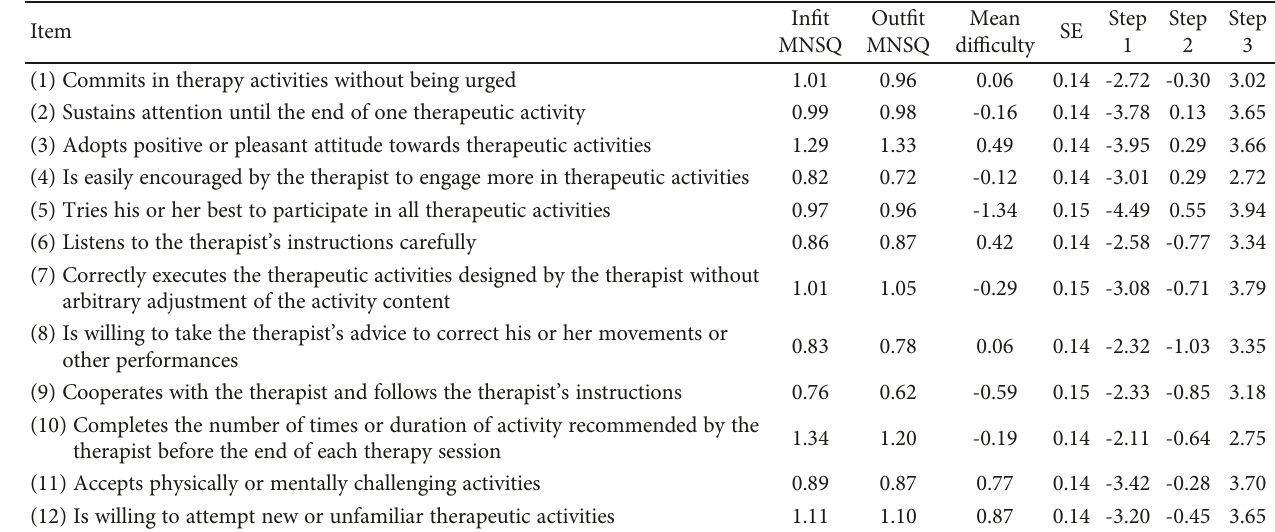
Table 2: The in fi t and out fi t mean square (MNSQ) statistics, mean item di ffi culties, and standard error (SE) of mean di ffi culty and step parameters of the occupational therapy engagement scale